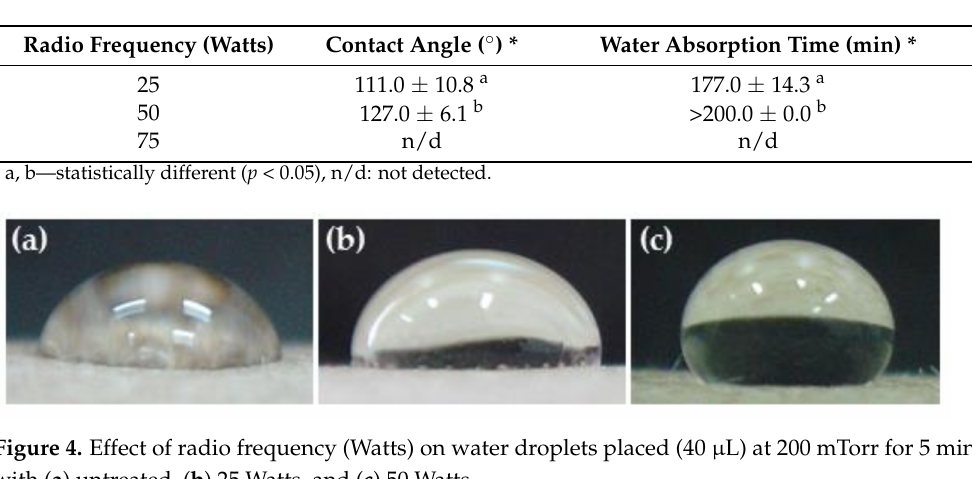
Figure 3. Effect of pressure on water absorption of untreated and treated KPs with plasma at 50 Watts for 5 min. Note: values indicated with the same letters are not significantly different at p < 0.05. Table 2. Effect of radio frequency (Watts) on the contact angles of untreated and treated KPs with plasma at 200 mTorr for 5 min.